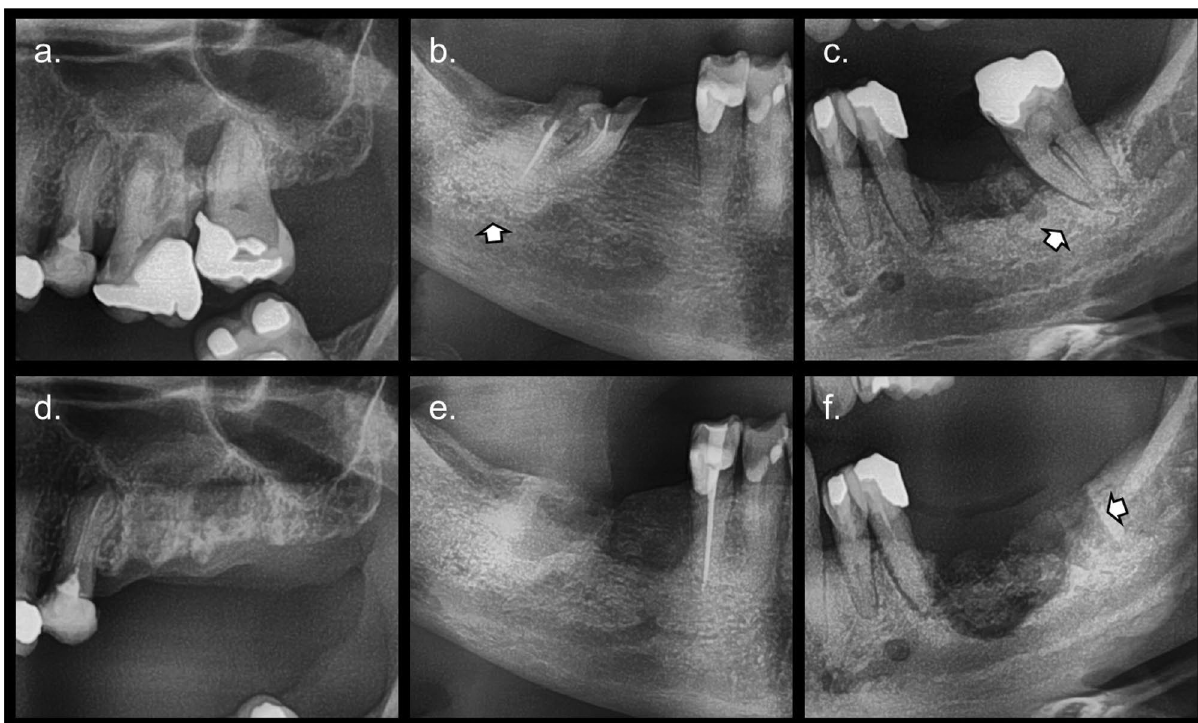
Figure 1. Cropped panoramic images showing pre-operative sites ( a – c ) and their respective post-operative evolution ( d – f ). Pre-operative images show presence of risk factors, teeth without endodontic treatment and with periapical lesion ( a , c ), incomplete endodontic filling in length and presence of caries ( b ), and sclerotic bone pattern ( b , c ; white arrow). All extraction sites developed osteonecrosis, showing a heterogenous bone pattern ( d , f ), a sclerotic bone pattern ( e ), visible extraction socket ( e , f ), persistence of the lamina dura ( f ; white arrow), and sequester formation ( f ).